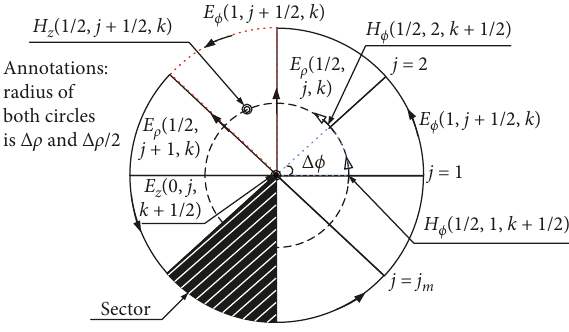
Figure 3: Top view of the field nearby the